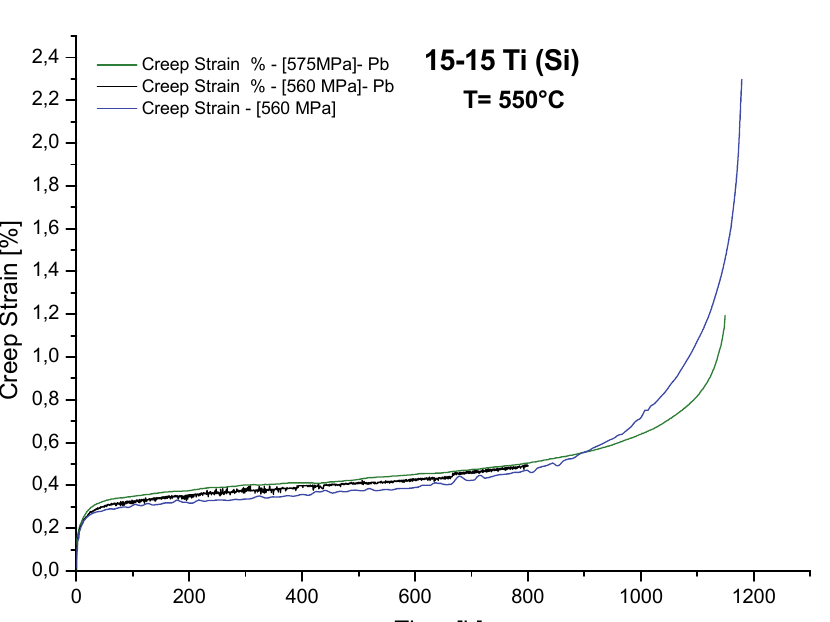
Figure 10: Creep curves of specimens tested in lead.